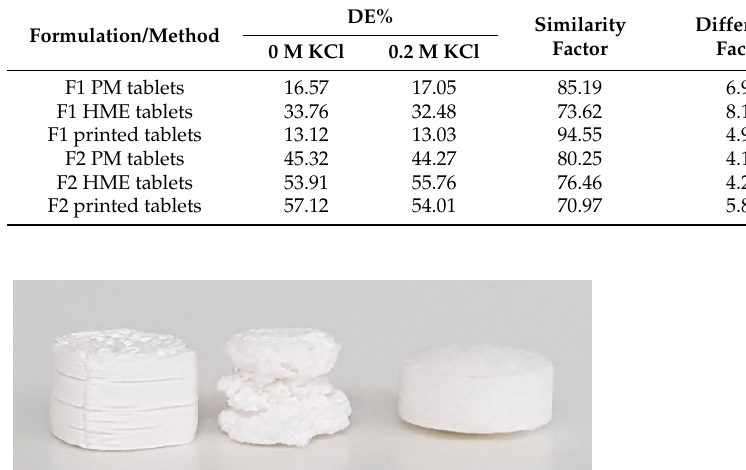
Table 3. Parameters extracted from dissolution profiles, including DE% values and similarity ( f 2 ) and difference ( f 1 ) factors of the dissolution profiles of the various tablets dissolved at different dip- ping rates .